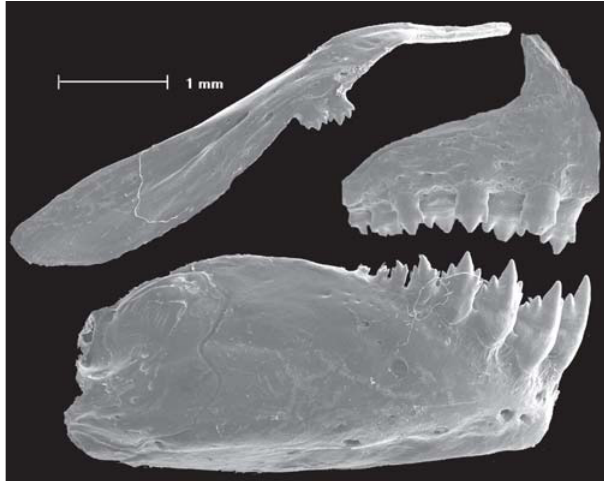
Table 1. Morphometric data of holotype (MCP 40916) and